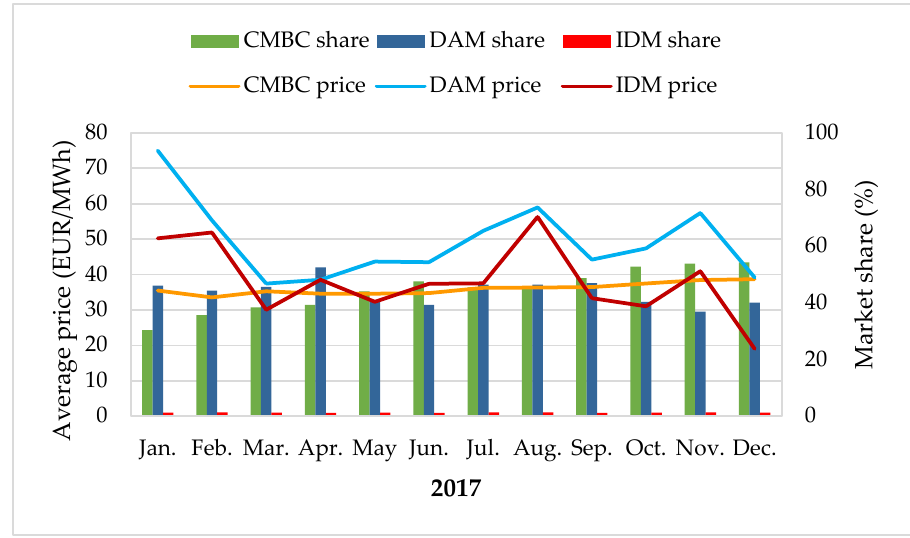
Figure 2. Electricity price and market share for CMBC, DAM, and IDM in 2017.